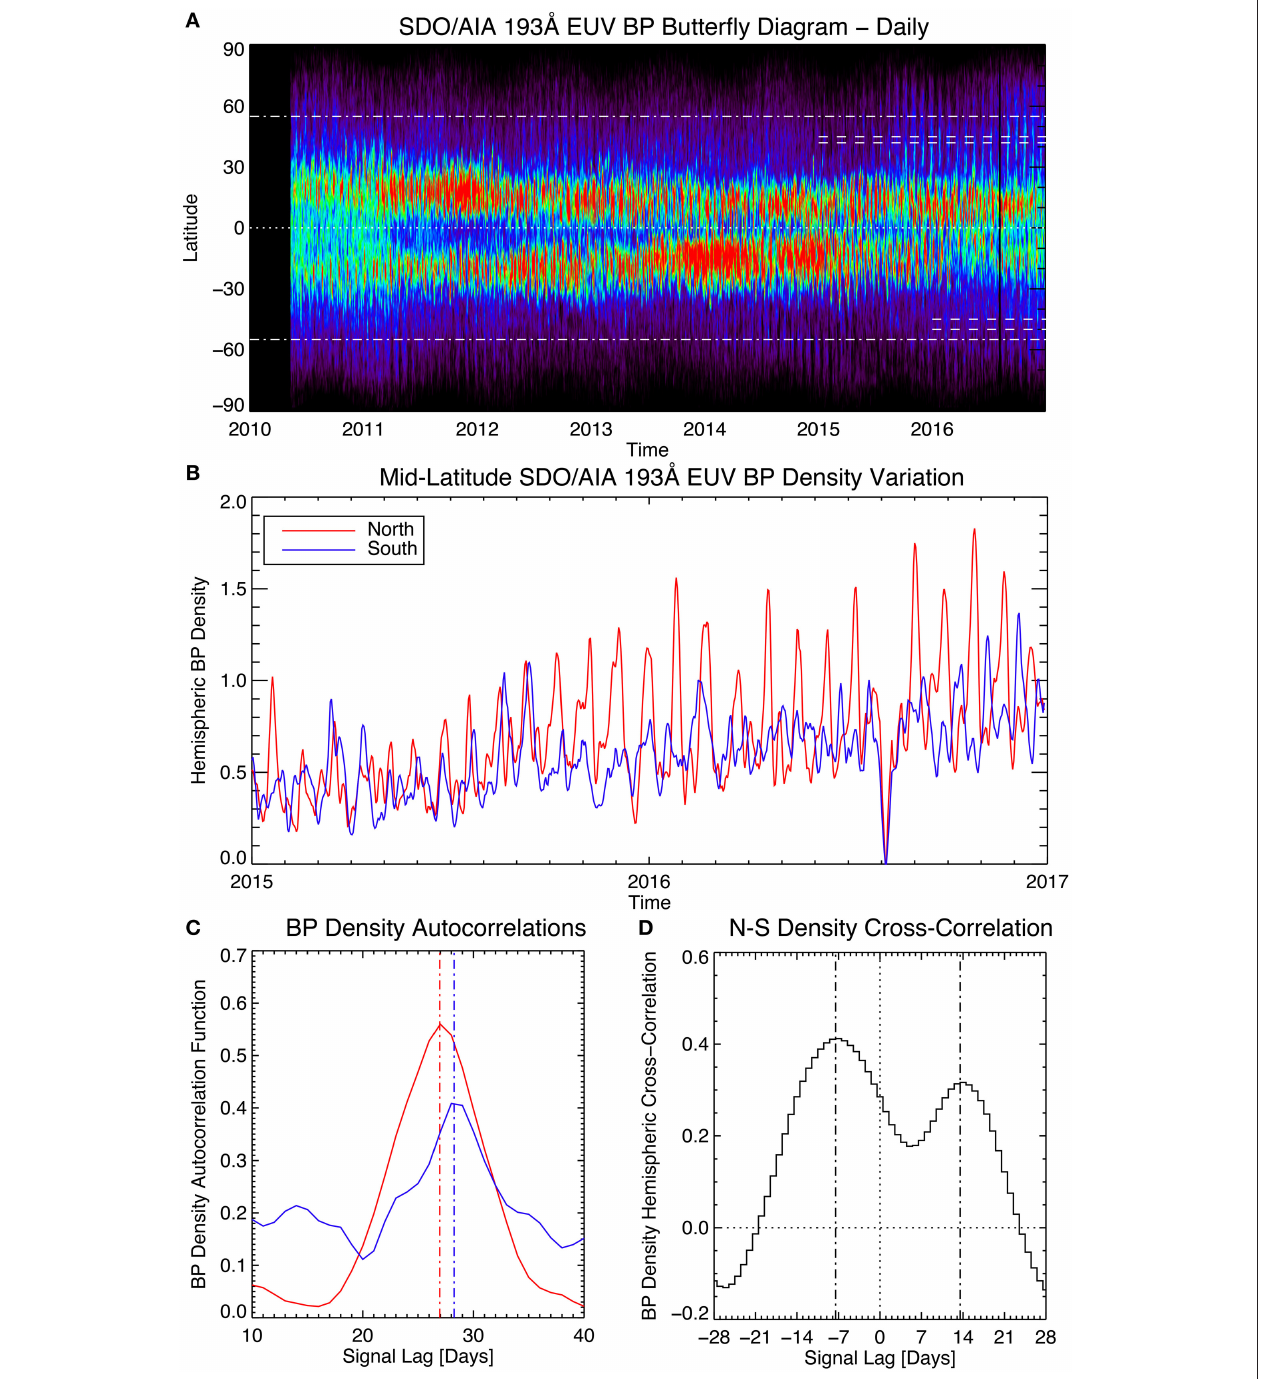
FIGURE 4 | From the latitude vs. time plot of SDO /AIA EUV BP density (A) where we identify mid-latitude regions, indicating the presence of solar cycle 25’s magnetic activity bands with dashed horizontal lines. The extracted hemispheric timeseries are shown in (B) with the northern variation in red and southern in blue. Panel (C) shows the auto-correlation of each mid-latitude hemispheric BP density timeseries where the dot-dashed vertical lines indicate the times of peak recurrence in each signal at 27 and 28 days for the northern and southern hemispheres, respectively. Panel (D) shows the cross-correlation between the hemispheric BP density profiles to illustrate that the disturbances present are not at the same solar longitude. We note the single point data drop-out in early August of 2016—it doesn’t impact the cross- or auto-correlation functions shown.